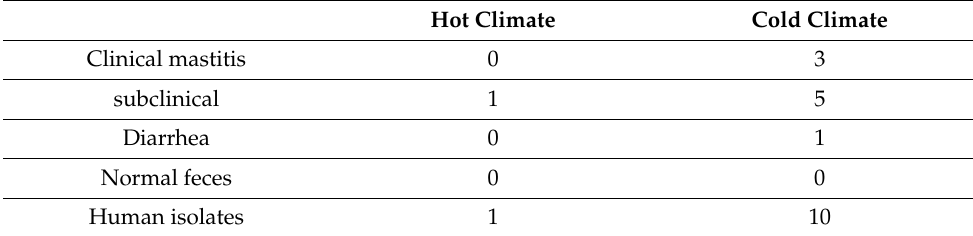
Table 5. Occurrence of STEC in relation to the hot and cold season.